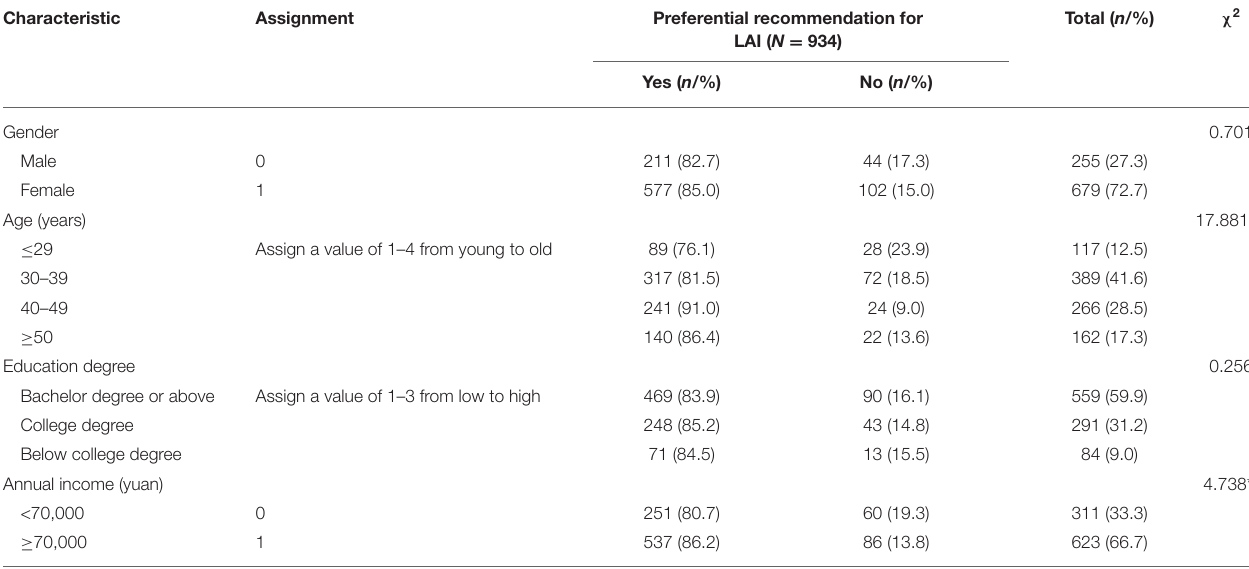
TABLE 1 | Univariate analysis of factors influencing the willingness of CPMP to recommend LAI in priority: Sociodemographic characteristics. Characteristic